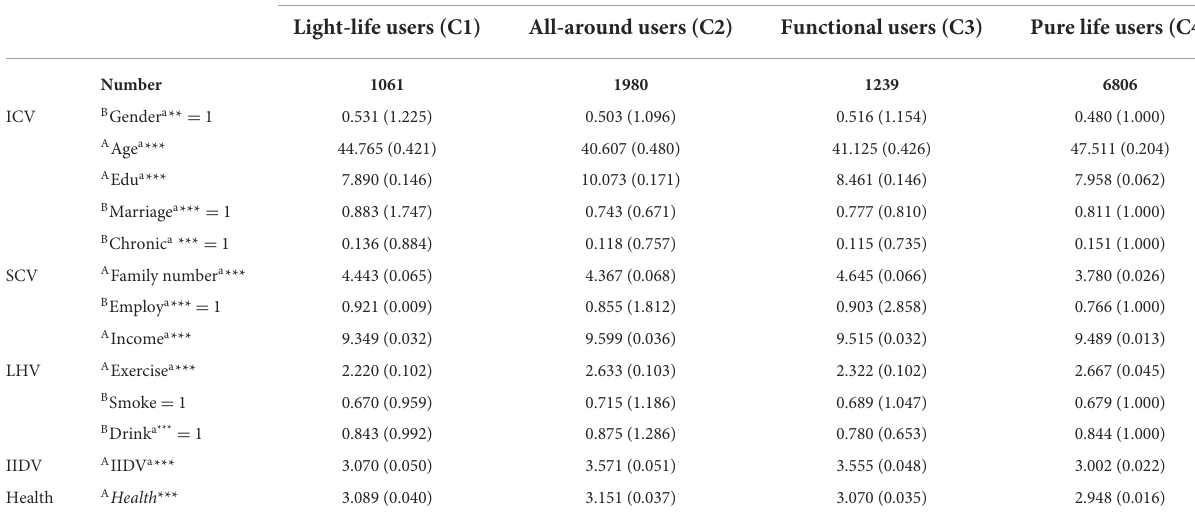
TABLE 4 ICV, SCV, LHV, health and IIDV of latent classes. Variable M(SD)/Prob(OR) Light-life users (C1) All-around users